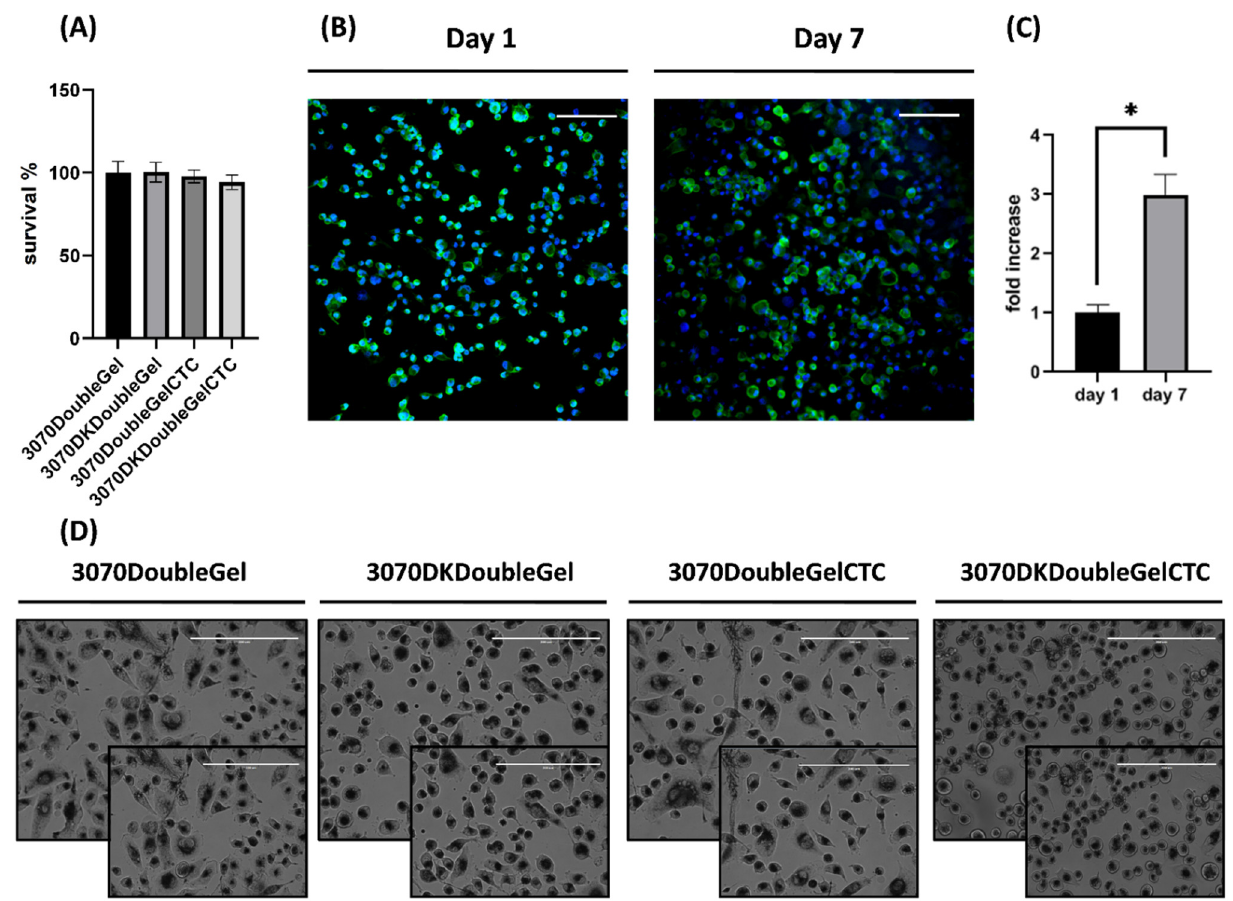
Figure 6. ( A ) Viability assay of VA-ES-BJ human epithelioid sarcoma cell line in a transwell culture system (indirect co-culture) with 3070DoubleGel, 3070DKDoubleGel, 3070DoubleGelCTC, and 3070DKDoubleGelCTC. ( B ) Representative immunofluorescence confocal images of VA-ES-BJ human epithelioid sarcoma cell line cultured in an empty patch at days 1 and 7. Actin filaments were stained with phalloidin (green) and nuclei were counterstained with dapi (blue). Magnification at 20×, scale bar = 200 µm. ( C ) Fold change in cell proliferation (cell number) day 7 versus day 1 (* p ˂ 0.05). ( D ) Morphological characterization of VA-ES-BJ human epithelioid sarcoma cell line after exposure to patches in the indirect co-culture. Architectural features of VA-ES-BJ with typical epithelial-appearing (ovoid or polygonal) cells mixed with fusiform cells with many intracytoplasmic vacuoles were maintained with 3070DoubleGel, 3070DKDoubleGel, and 3070DoubleGelCTC while morphological changes such as rounding up were observed with a combination treatment (3070DKDoubleGelCTC). Magnification 20×, scale bar = 200 µm.